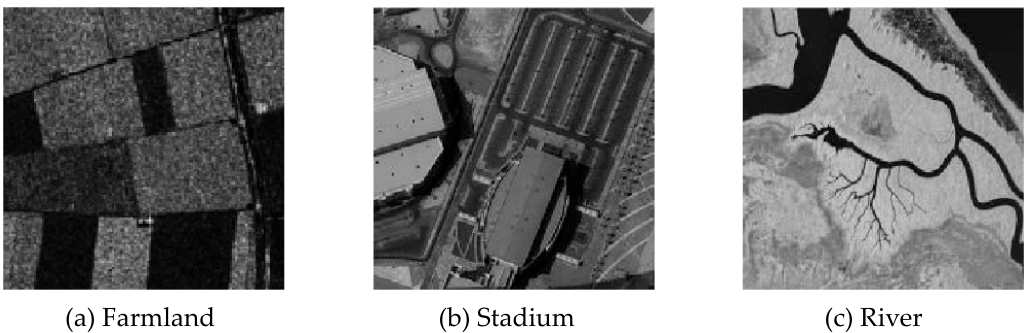
Figure 15. Original remote sensing images.